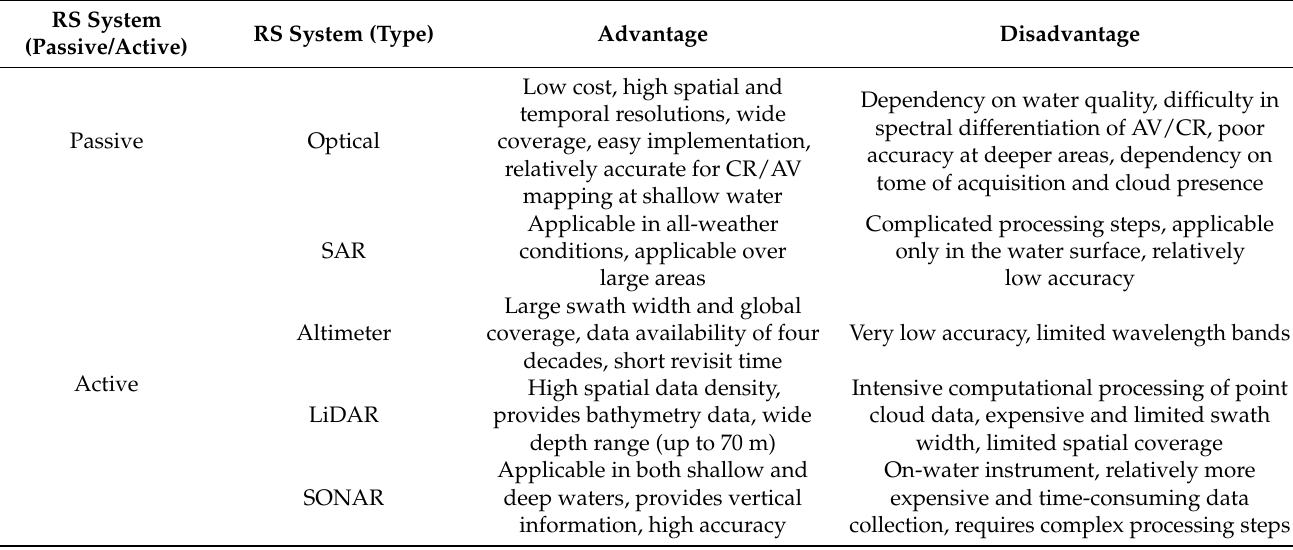
Table 6. Different RS systems for underwater ocean studies along with their advantages and disad-